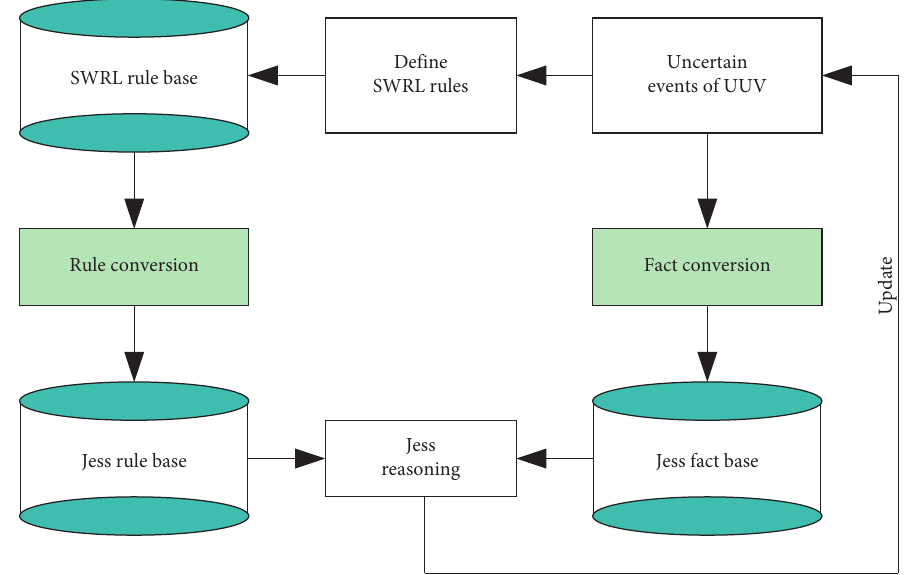
Figure 5: Fact base and rule base of the ontology and SWRL rule conversion inference